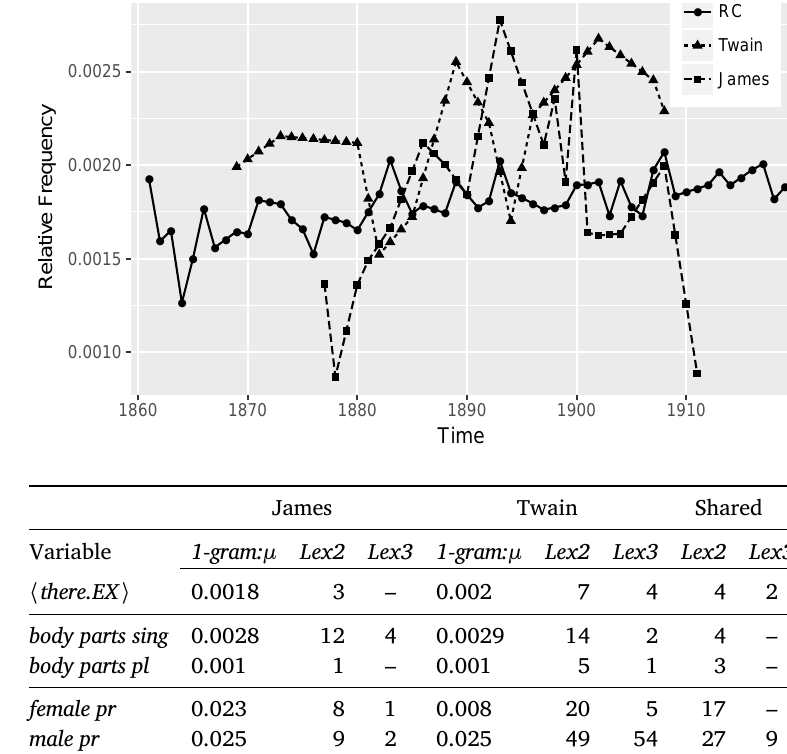
Figure 8: Existential h there i for all three